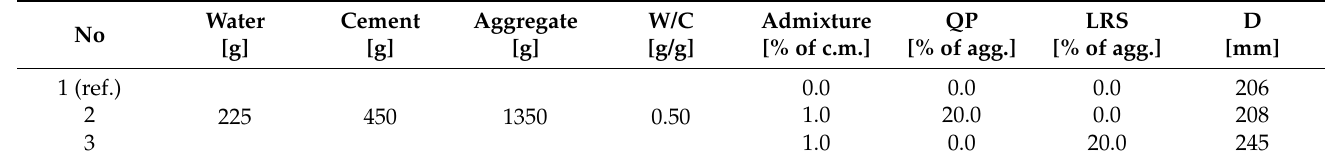
Table 5. Compositions of mortars with/without micro-filler (QP—quartz powder; LRS—lunar regolith simulant) and flow table test results (D—mean value of the flow diameter measured in two perpendicular